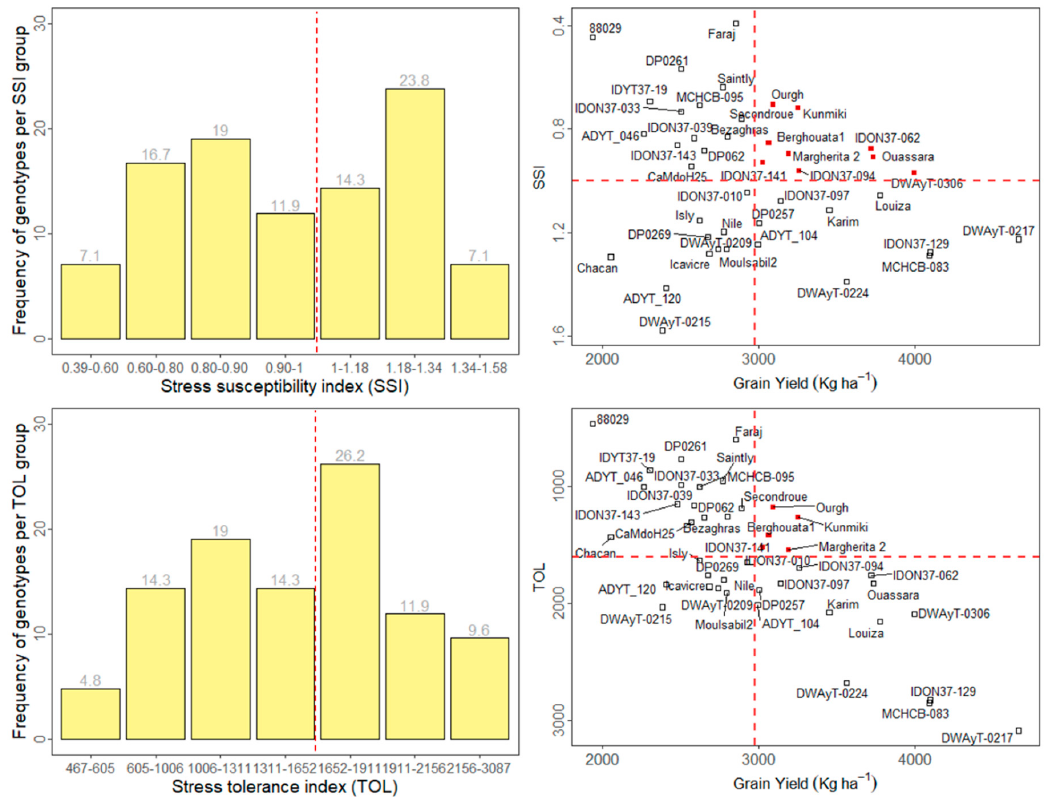
Figure 4. Two different stress tolerance indices SSI (stress susceptibility index) and TOL (tolerance index) of grain yield, comparing plastic tunnel-mediated heat stress with normal conditions for the 42 durum wheat genotypes. The bars plot shows the frequency distribution of SSI and TOL for the genotypes tested. The dashed red lines mark the separation between tolerant (left) and susceptible (right) genotypes. The scatter plot shows the yield performance of genotypes tested under normal conditions against each of SSI and TOL. The vertical dashed red lines indicate the average GY. The horizontal dashed red lines indicate the cut-off value for tolerant vs. susceptible genotypes for each index. Red dots indicate genotypes that were identified as superior by both bi-plots.